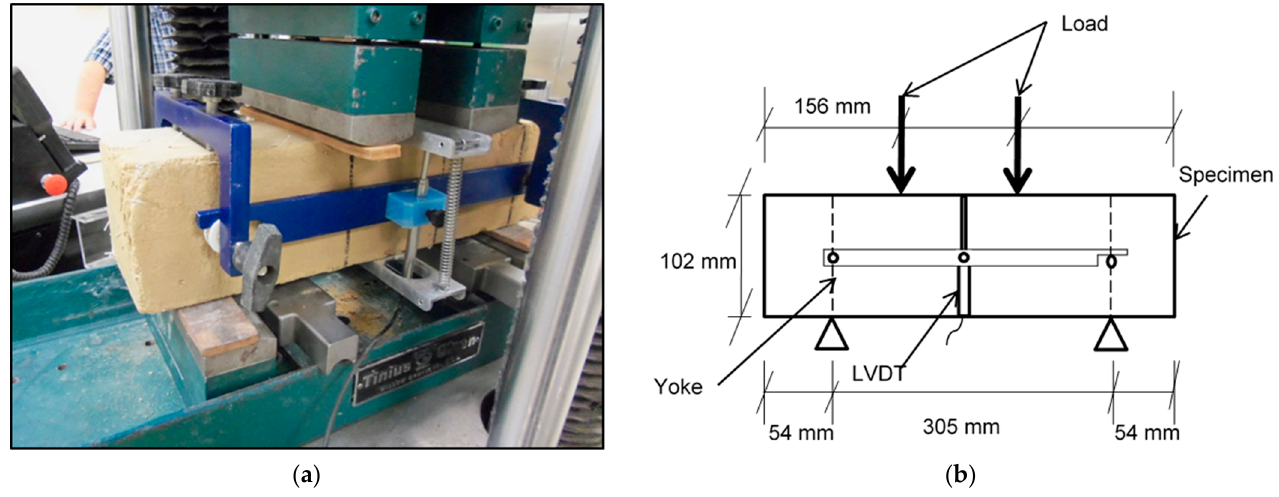
Figure 3. Test setup: ( a ) photograph, ( b ) schematic drawing.